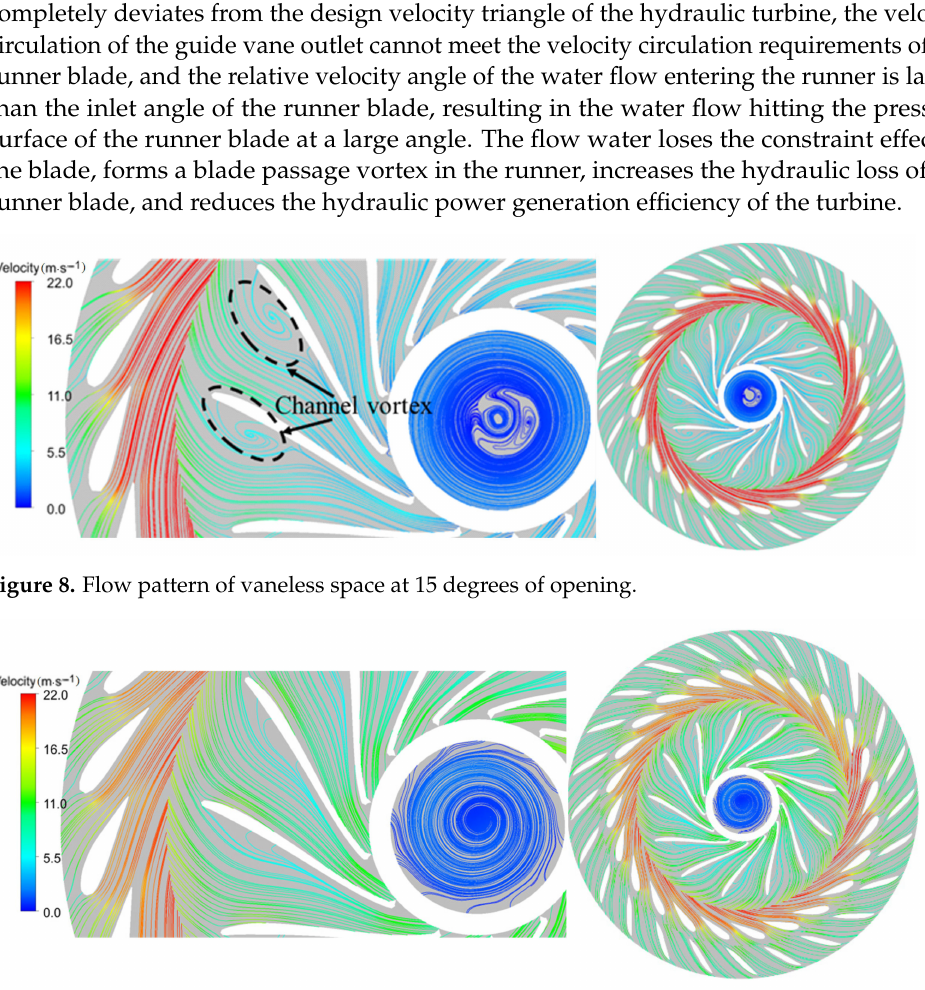
Figure 9. Flow pattern of vaneless space at 20 ◦ of